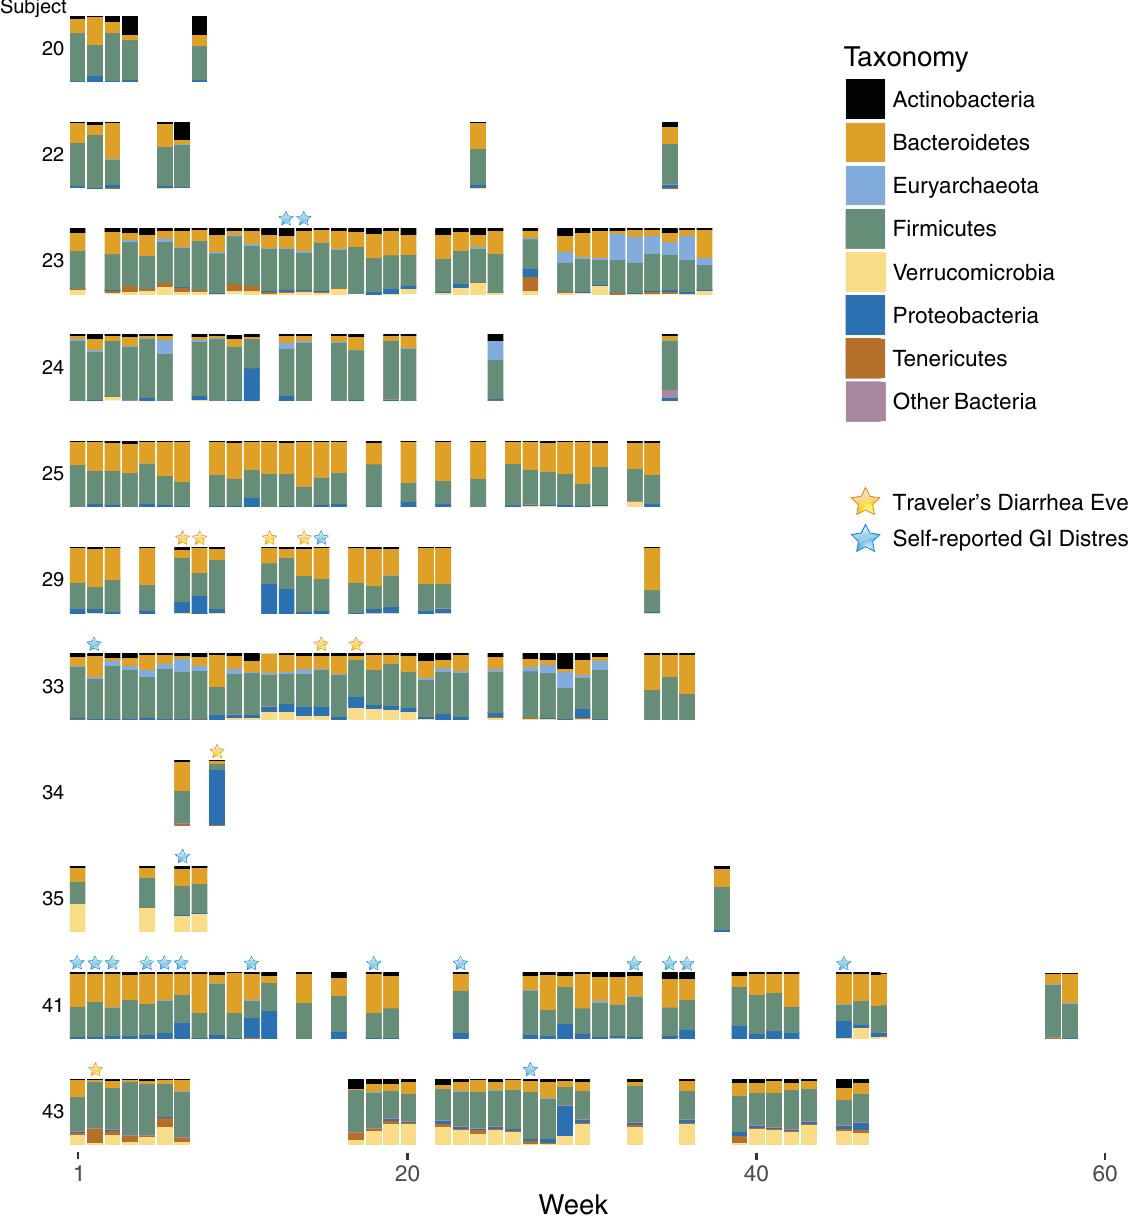
Fig 2. Study 2b Microbial phyla over time for all subjects. The relative abundance of the most abundant phyla are shown for each subject along with the weekly time points where samples were collected. Week 1 indicates the first week of deployment overseas. TD events are indicated with a gold star and self-reported GI distress is indicated by blue